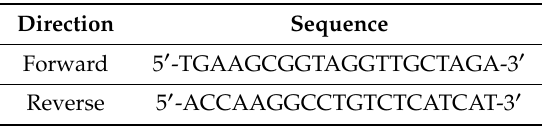
Table 3. Primer pairs for ChIP